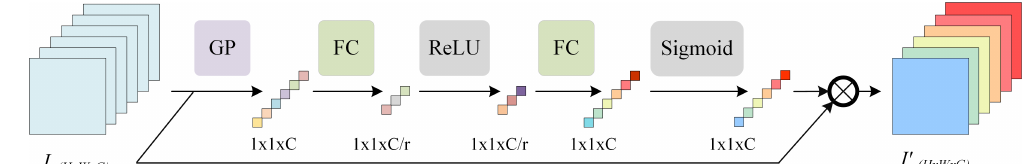
Figure 6. The channel attention